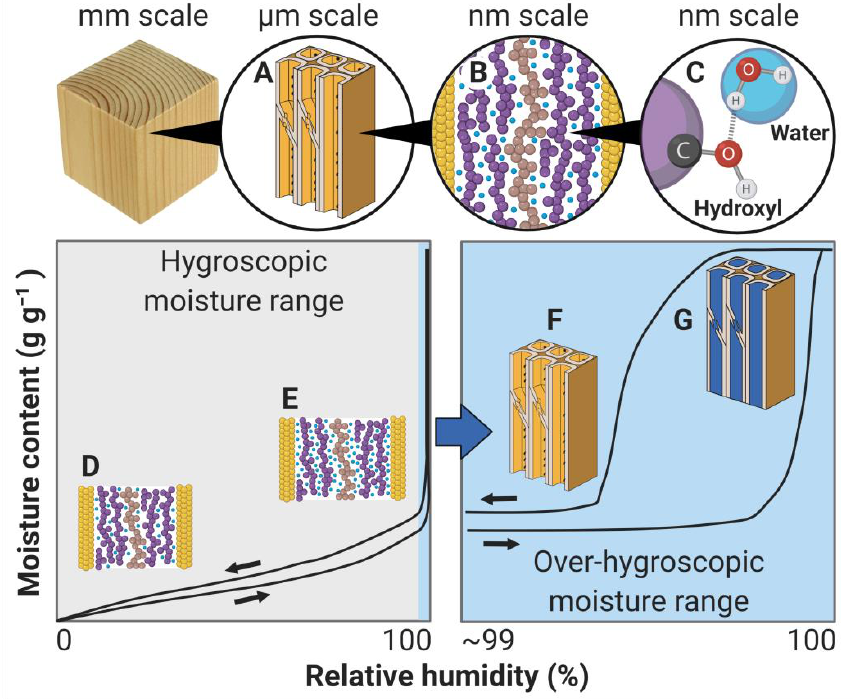
Figure 2. Moisture in wood can be found in both the porous capillary structure ( A ) and the solid cell wall material ( B ), where the water molecules interact with hydroxyls on the cell wall polymers ( C ). Diagrams depict equilibrium moisture content as a function of relative humidity (sorption isotherms) in both the hygroscopic (left) and over-hygroscopic (right) moisture ranges. In the hygroscopic moisture range, changes in moisture content are dominated by changes in moisture content (blue spheres) within the cell wall material ( D , E ), whereas changes in moisture content (blue filling in macro-voids) in the capillary structure ( F , G ) becomes dominant in the over-hygroscopic moisture range. Moisture history dependence is indicated by arrows indicating equilibrium reached by increasing relative humidity (absorption isotherm) and decreasing relative humidity (desorption isotherm).